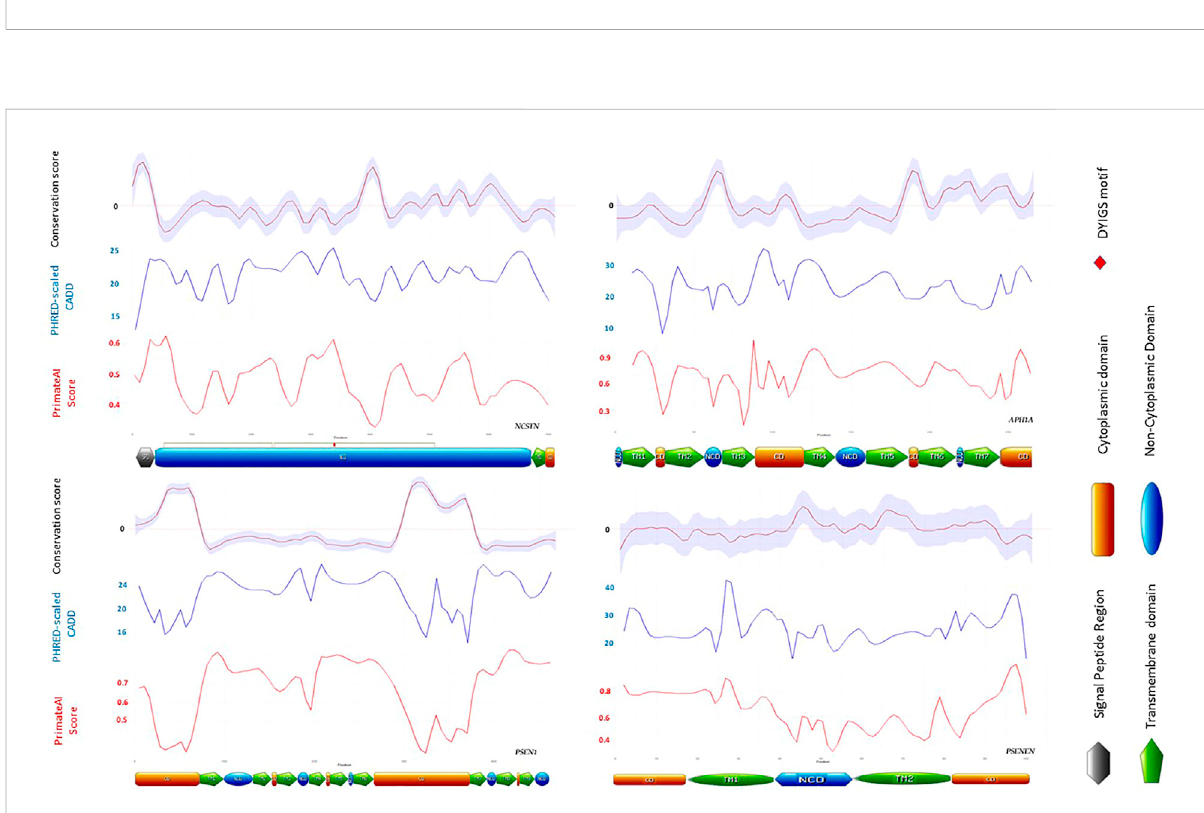
FIGURE 3 Distribution of CADD, PrimateAI and Rate4S scores across protein domains of the four GSC subunits. The nicastrin DYIGS motif illustrated by a red marker is highly conserved, and variation in this region is highly